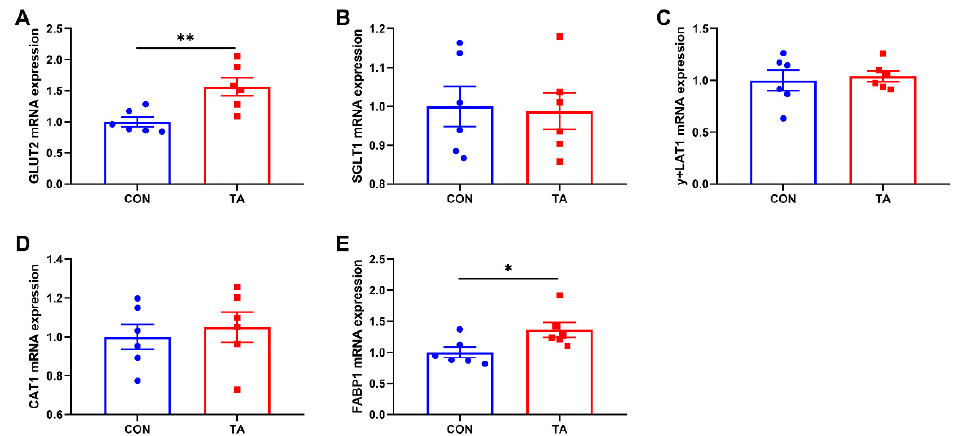
Figure 6. Effects of tannic acid extracted from Galla chinensis supplementation on expressions of nutrient transporters genes in intestinal mucosa of broiler chickens. ( A ) Glucose transporter type 2 (GLUT2); ( B ) Na+/glucose cotransporter (SGLT1); ( C ) y+L amino acid transporter 1 (y+LAT1); ( D ) Cationic amino acid transporter 1 (CAT1); ( E ) Fatty acid binding protein-1 (FABP1). CON, broiler chickens fed basal diet; TA, broiler chickens fed basal diet supplemented with 300 mg/kg microencapsulated tannic acid extracted from Galla chinensis . Values are mean ± standard error ( n = 6). Differences between treatments were displayed by * p < 0.05 and ** p < 0.01.